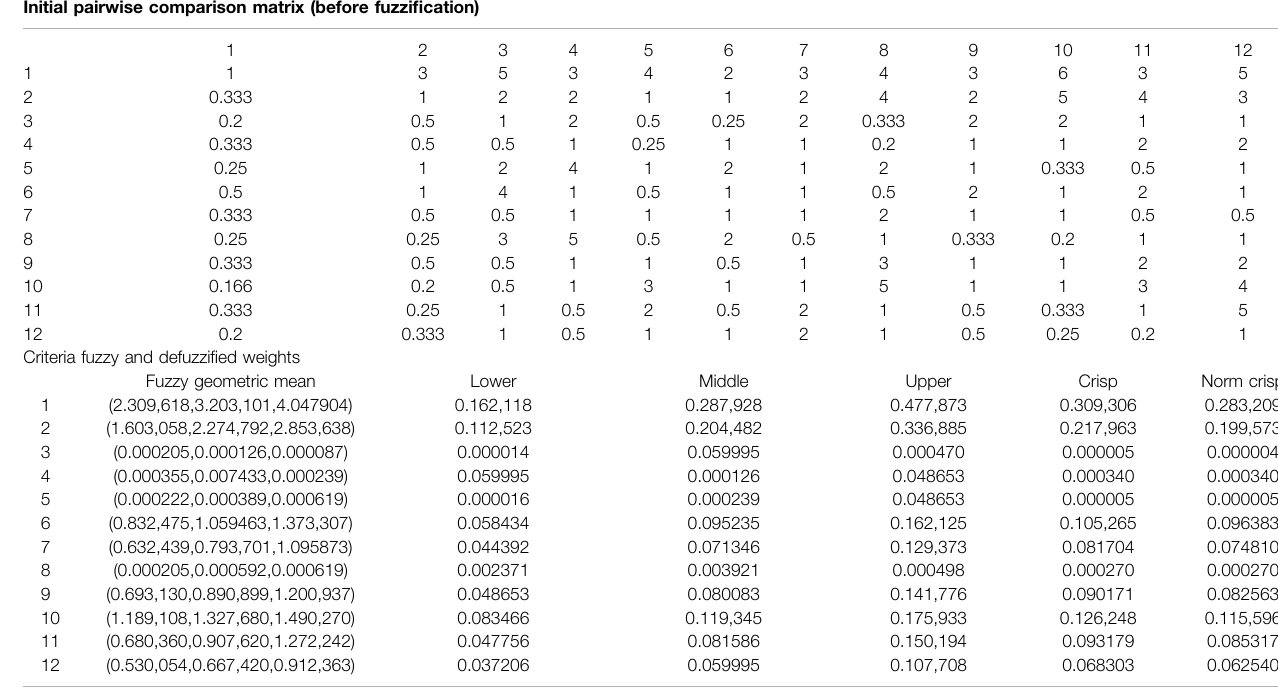
TABLE 4 | Fuzzy AHP results per criteria category – Category